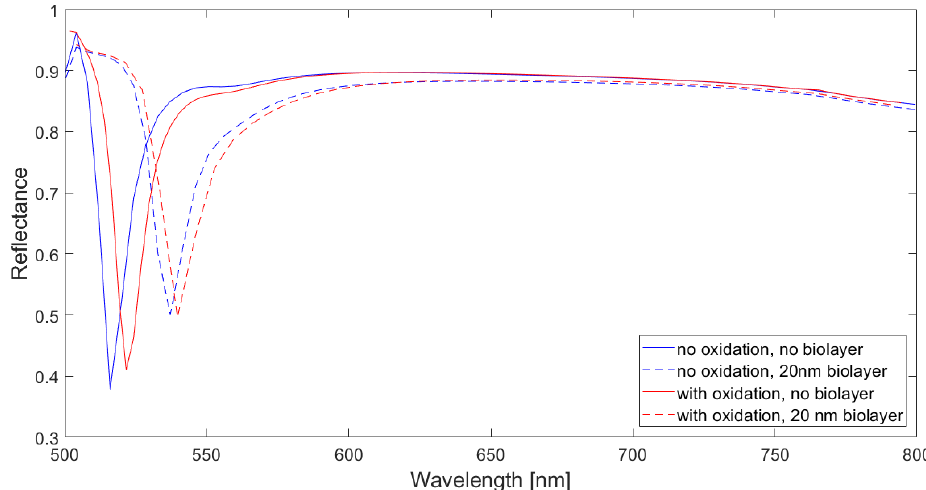
Figure 7. Reflectance spectra of a 500 nm period Al/polymer plasmonic 2D crystal ( d = 150 nm, h = 150 nm) without (blue curves) and with (red curves) a 5 nm thick Al oxide layer. Solid and dashed lines correspond to the absence or presence of a 20 nm thick biolayer, respectively.